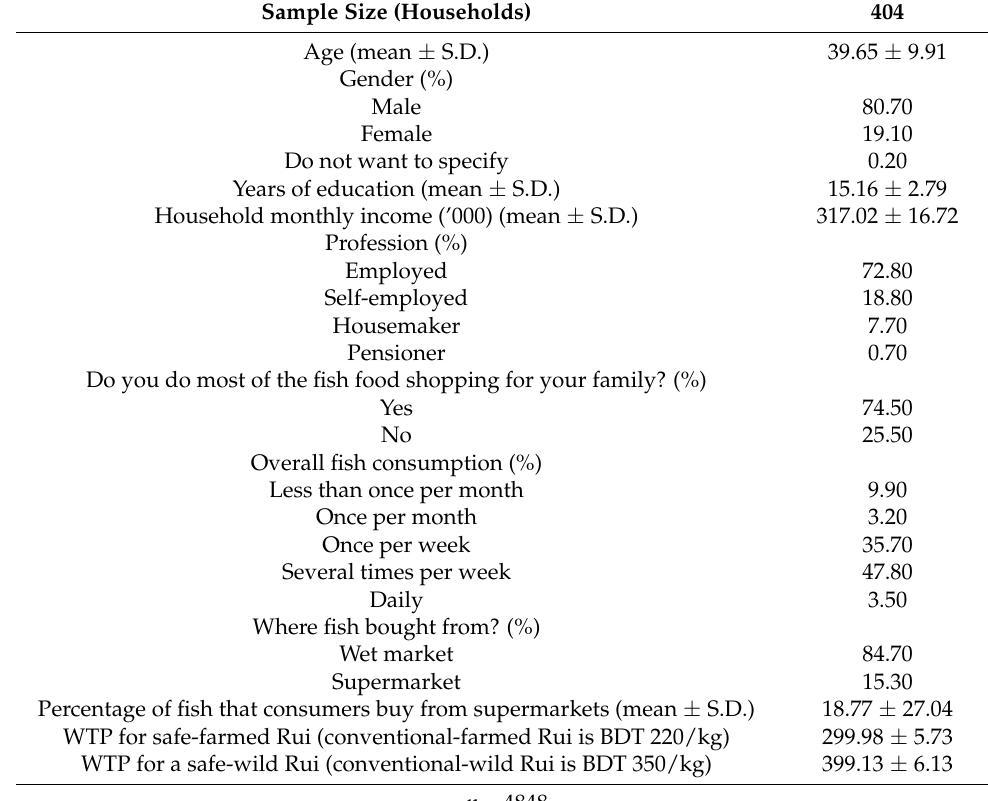
Table 4. Descriptive statistics of the demographic, and psychographic variables and the preference patterns for chilled